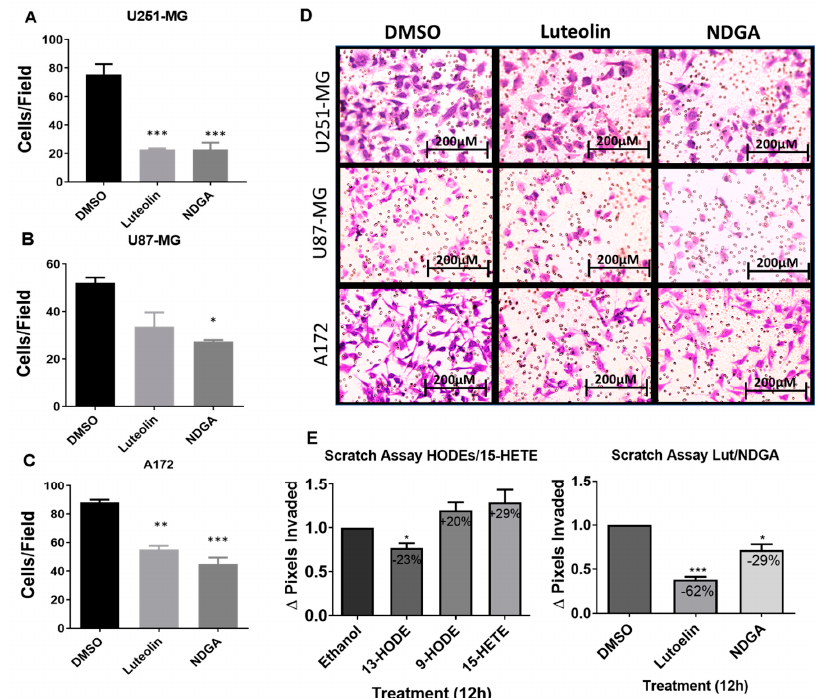
Figure 6. Transwell migration of the GBM cell line after treatment with the pharmacological inhibitors. Histograms expressing the cell number after 8-µm pore migration show a decrease in Transwell migration after luteolin and NDGA treatments ( A – C ). The values represent the arithmetic mean of numbers that were individually obtained with the mean of ten di ff erent visual fields ± standard error. Representative images of the cells after 24 h of migration stained with violet crystal ( D ). 100 × magnification, captured by light microscopy. N = 2, in duplicate. Wound-healing assay with cell line T98G. Histograms show the e ff ects of 5 µ M treatments of 13-HODE, 9-HODE, and 15-HETE (left) and 15 µ M treatments of 15-LOX inhibitor (luteolin) and 40 µ M treatments of 15 / 12-LOX inhibitor (NDGA) (right) on T98G cell migration ( E ). A decrease in migration was observed in the 13-HODE treatment compared to its vehicular control (ethanol). An inhibitory e ff ect was observed with the luteolin and NDGA treatments compared to their control, dimethyl sulfoxide (DMSO). N = 3. * p < 0.05, ** p < 0.01, and *** p <